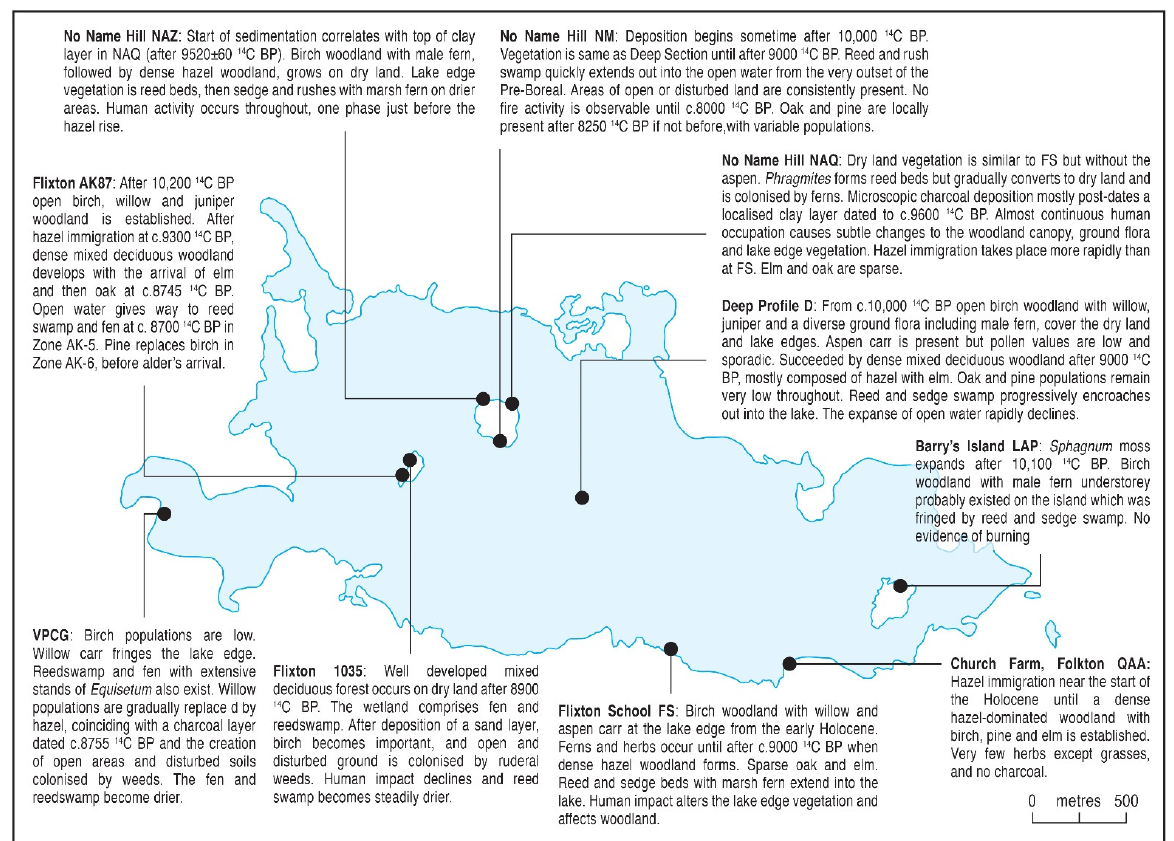
Figure 15. Correlation of palaeoenvironmental change in this paper’s sites at Palaeolake Flixton c.10,000–c. 7000 14 C BP (Early to Mid-Holocene–cf. Pre-Boreal and Boreal), derived from zones D 5–7, NM 1–6, NAQ 1–6, NAZ 1–3, AK87 1–7, 1035 1–4, VPCG 1–4, FS 1–7 and QAA 6. 5.2.3. Mid-Holocene c.7000 to 5000 14 C BP (cf. Atlantic; Zones D 8, NM 7, AK87 8, 1035 5, QAA 7, LAL 1 and LAP 4–5) Seven of the new profiles in this study contain sediments of mid-Holocene, post Alnus -rise, age (Figures 13 and 16) and this important pollen stratigraphic change [97,98] is used to define the mid-Holocene period of the Mesolithic. There is aquatic pollen at profile D but not in the more marginal profiles, which contain only the semi-aquatic Typha angustifolia . The lake was almost completely terrestrialised by this time [25], with small areas of shallow open water only in the centre. This would have changed the pollen source area, with a more local pollen rain to profile D and the other lake centre sites, reducing the regional signal. This period saw the completion of the assembly of the regional forest, with Ulmus and Quercus increasing and Alnus becoming a significant component. The timing and degree of the alder expansion was strongly asynchronous, with a very wide range for its rise to high frequencies, and might well have depended on soil conditions, although other triggers for its expansion would have existed, such as disturbance [22]. Alnus ’s main role locally was as a dominant in the carr that formed the landward fringe of the lake-edge wetland vegetation as sedimentation continued and wetland successions progressed. The available radiocarbon ages for its expansion show that it was late arriving on the islands in the lake, dating to 5990 ± 90 14 C BP at AK87 and 6160 ± 50 14 C BP at NM although the date of 6815 ± 110 14 C BP at Flixton F1035 is nearer the c. 7000 BP expected